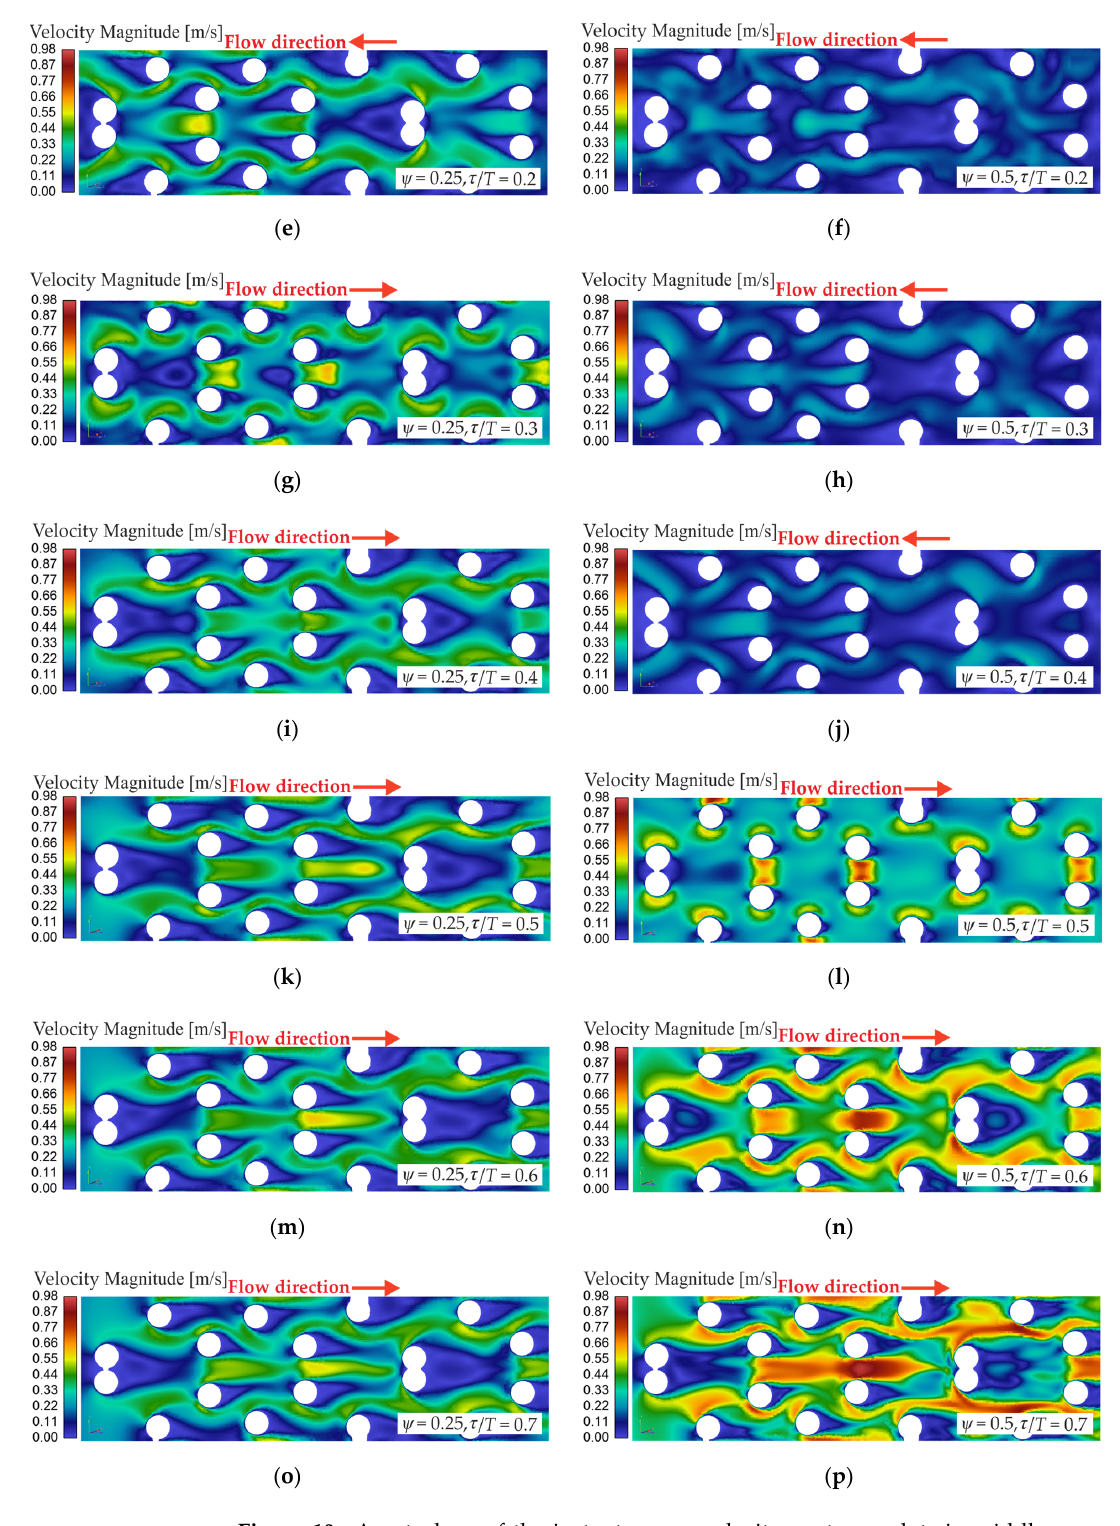
Figure 10. A cut plane of the instantaneous velocity contours plots in middle cross section for pulsating flow at ε = 0.743, Re = 25, ( A / D ) St = 0.344. Unit is m/s. ( a ) ψ = 0.25, τ / T = 0. ( b ) ψ = 0.5, τ / T = 0. ( c ) ψ = 0.25, τ / T = 0.1. ( d ) ψ = 0.5, τ / T = 0.1. ( e ) ψ = 0.25, τ / T = 0.2. ( f ) ψ = 0.5, τ / T = 0.2. ( g ) ψ = 0.25, τ / T = 0.3. ( h ) ψ = 0.5, τ / T = 0.3. ( i ) ψ = 0.25, τ / T = 0.4; ( j ) ψ = 0.5, τ / T = 0.4. ( k ) ψ = 0.25, τ / T = 0.5. ( l ) ψ = 0.5, τ / T = 0.5. ( m ) ψ = 0.25, τ / T = 0.6. ( n ) ψ = 0.5, τ / T = 0.6. ( o ) ψ = 0.25, τ / T = 0.7. ( p ) ψ = 0.5, τ / T =